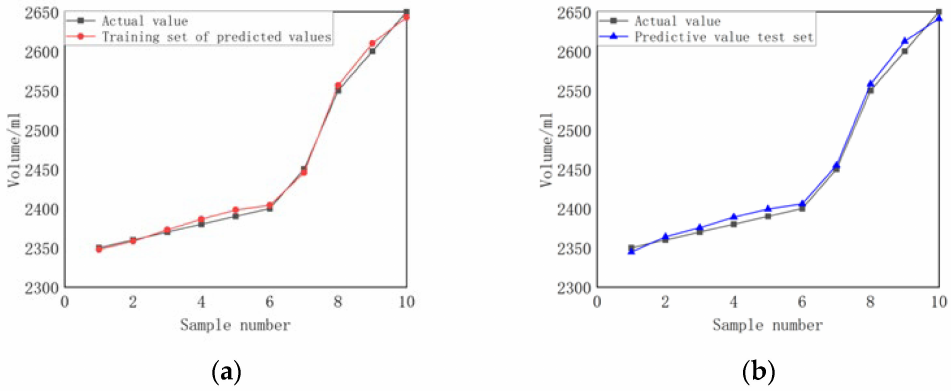
Figure 3. Results of the particle-swarm-optimization support-vector-machine algorithm. ( a ) Results of training set; ( b ) Results of test set.